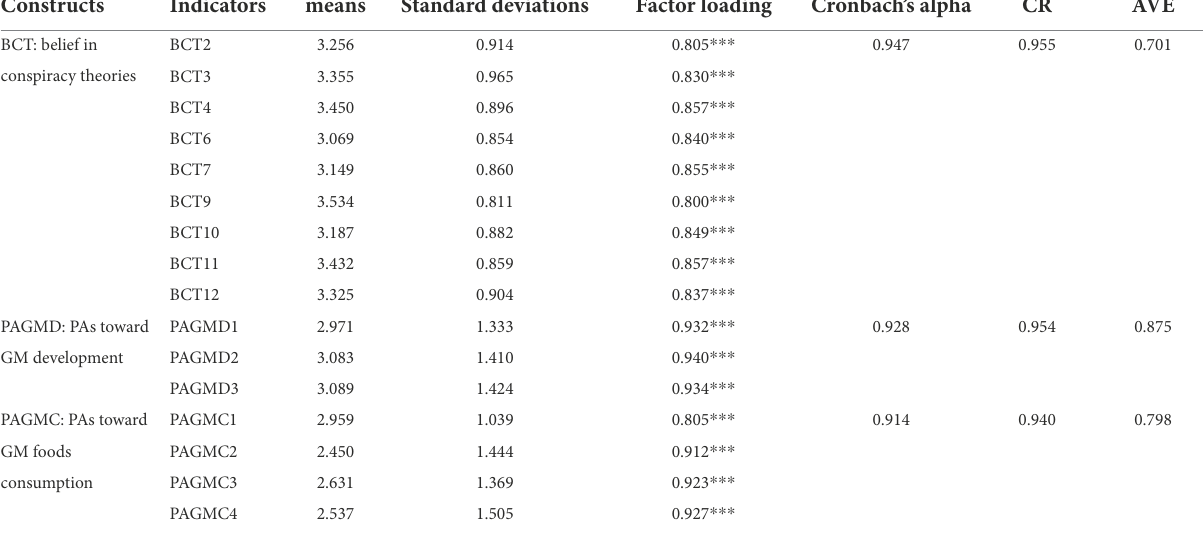
TABLE 2 The convergent validity and reliability of reflective